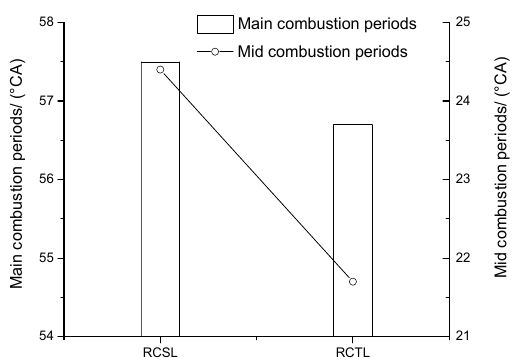
Figure 14. Instantaneous and cumulative HRR for two combustion chambers under 92 kW load.